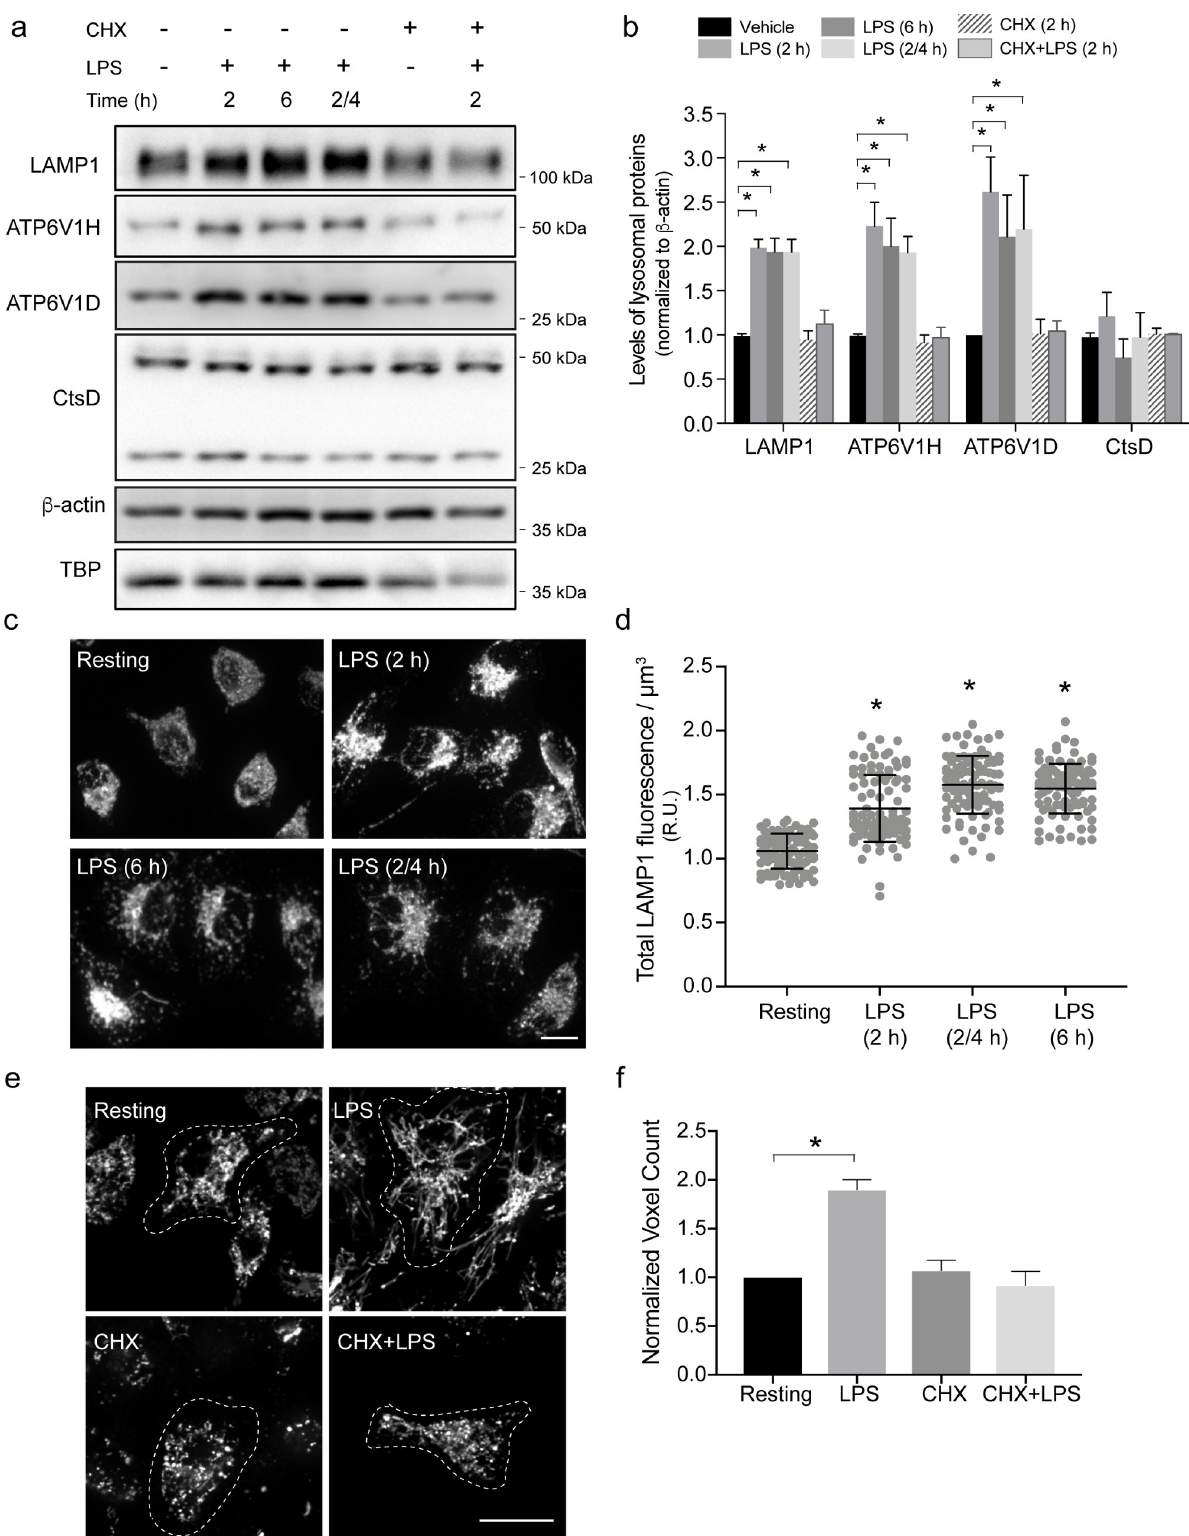
Fig 2. Lysosome remodelling requires protein biosynthesis. (a) Western blot analysis of whole-cell lysates from resting primary macrophages or macrophages exposed to the indicated combinations and time of LPS and CHX. (b) Quantification of Western blots showing the levels of LAMP1,